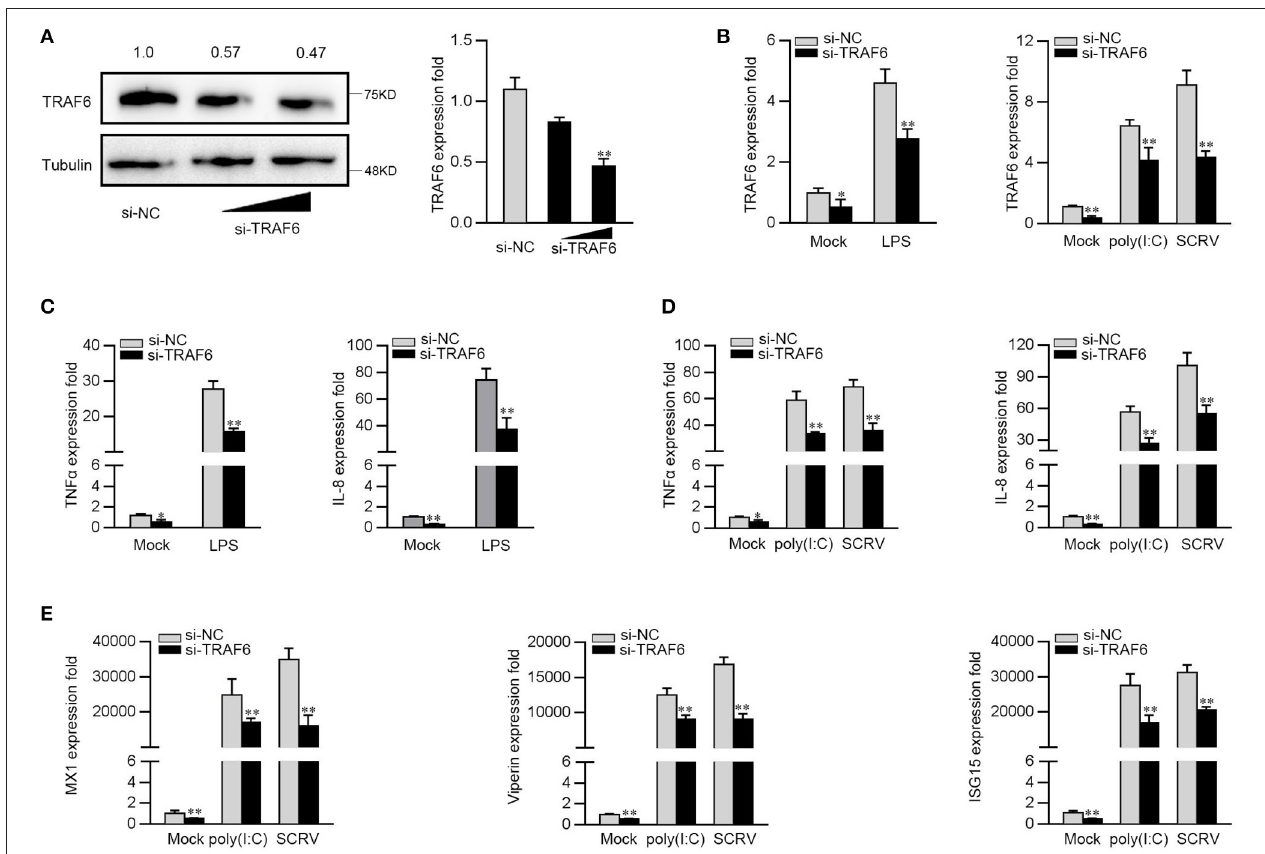
FIGURE 6 | Knockdown of TRAF6 depress the expression of inflammatory factor and antiviral genes. (A) MKC were transfected with control siRNA (si-NC) or si-TRAF6 for 48h, then TRAF6 protein (left panel) and mRNA (right panel) level were determined by western blot and qRT-PCR, respectively. (B) MKC were transfected with contrl siRNA (si-NC) or si-TRAF6 for 48h, the macrophages (MKC) were treated with LPS (left panel), poly(I:C) or SCRV (right panel), respectively. The expression levels of TRAF6 by qRT-PCR. (C) MKC cells were transfected with si-NC or si-TRFA6 for 48h, and treated with LPS for 6h. The expression levels of TNF α and IL-8 were determined by qRT-PCR. (D,E) After transfection of si-NC or si-TRAF6, MKC cells were treated with poly (I:C) or SCRV for another 12h or 18h, respectively. The expression levels of TNF- α , IL-8 (D) , MX1, Viperin, and ISG15 (E) . All data are presented as the means ± SE from three independent triplicated experiments. ** p < 0.01; * p < 0.05 vs. the controls.